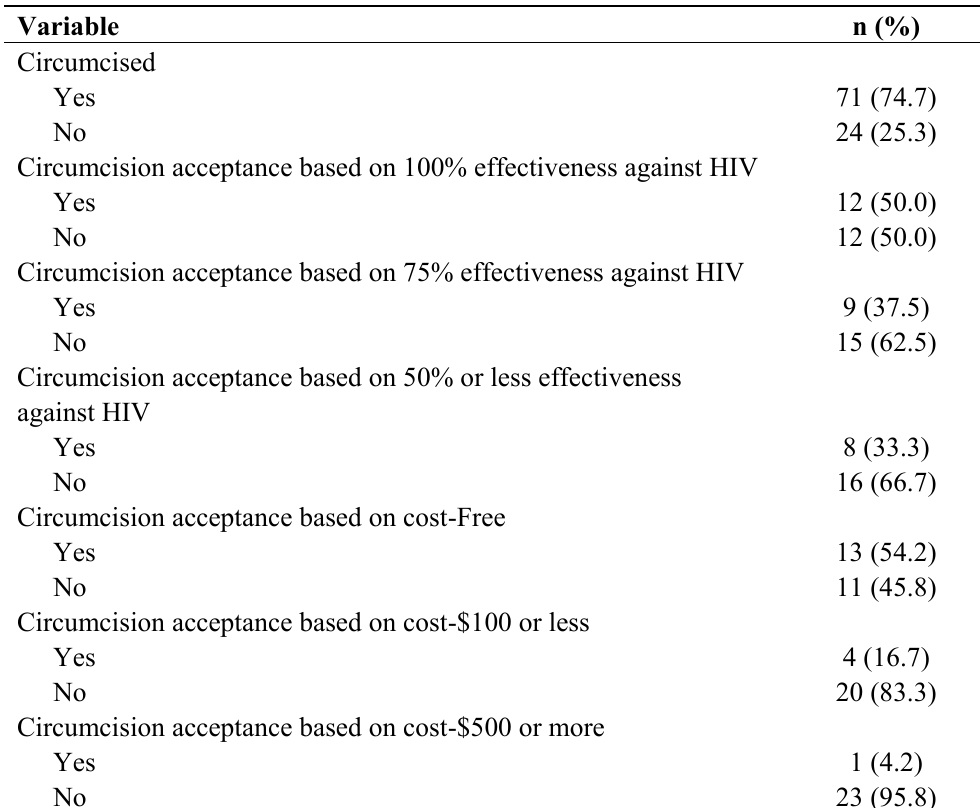
Table 3. Acceptance of Circumcision as a Safe Sex Measure ( N =